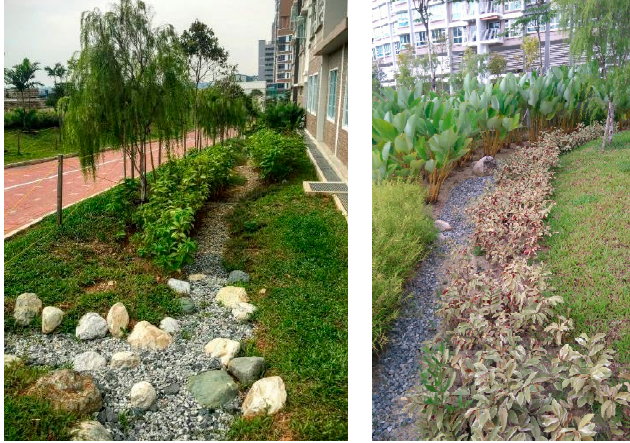
Figure 5. Photos of vegetated swales in Waterway Ridges.